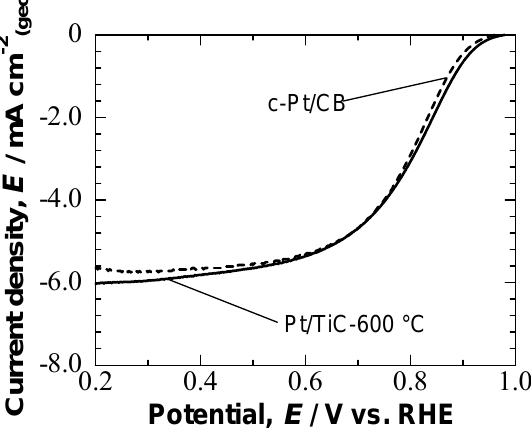
Figure 5. Hydrodynamic voltammograms for the ORR at Nafion-coated Pt/TiC-600 °C and c-Pt/CB in O 2 -saturated 0.1 M HClO 4 solution at 25 °C. Rotating rate was 1500 rpm, and the potential sweep rate was 5 mV s − 1